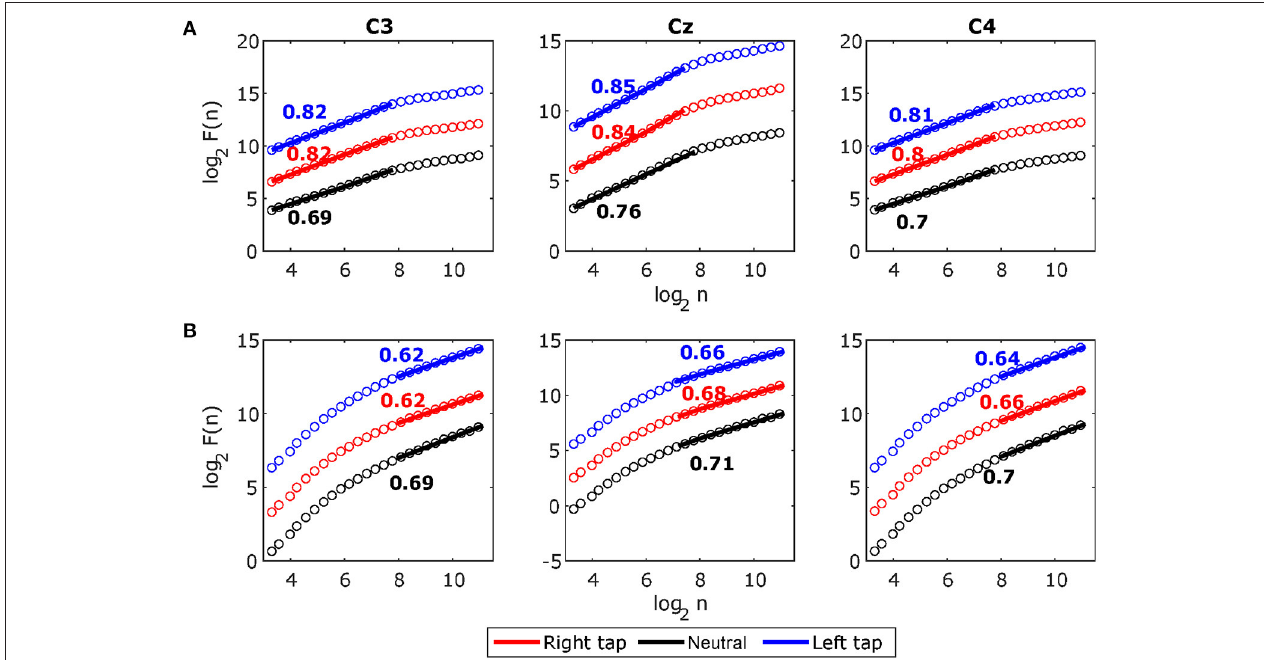
FIGURE 5 | The grand average detrended fluctuation analysis (DFA) plots for stitched broadband electroencephalography (EEG) and alpha amplitude fluctuations during movement in C3, Cz, and C4. (A) The grand average DFA plots for stitched broadband EEG during right tap (red), left tap (blue), and resting state (black) for all the participants. This EEG segment is extracted from − 1 to + 1 s of the movement onset. The Hurst exponents H BB obtained from the slope of the fitted line to the DFA plots are shown. (B) The grand average DFA plots for stitched alpha amplitude fluctuations H alpha . The broadband DFA exponents are valid over shorter scales as there is a crossover point at 8 (i.e., log 2 of 256 samples) and the alpha envelope DFA exponents are valid over longer timescales. With sampling frequency of 128 Hz, smallest DFA box size of 10 samples ( log 2 10 = 3.32) correspond to 78 ms, crossover point at 256 samples ( log 2 256 = 8) correspond to 2 s, and largest DFA box size of 2,241 samples ( log 2 2241 = 11.13) correspond to 17.5 s.